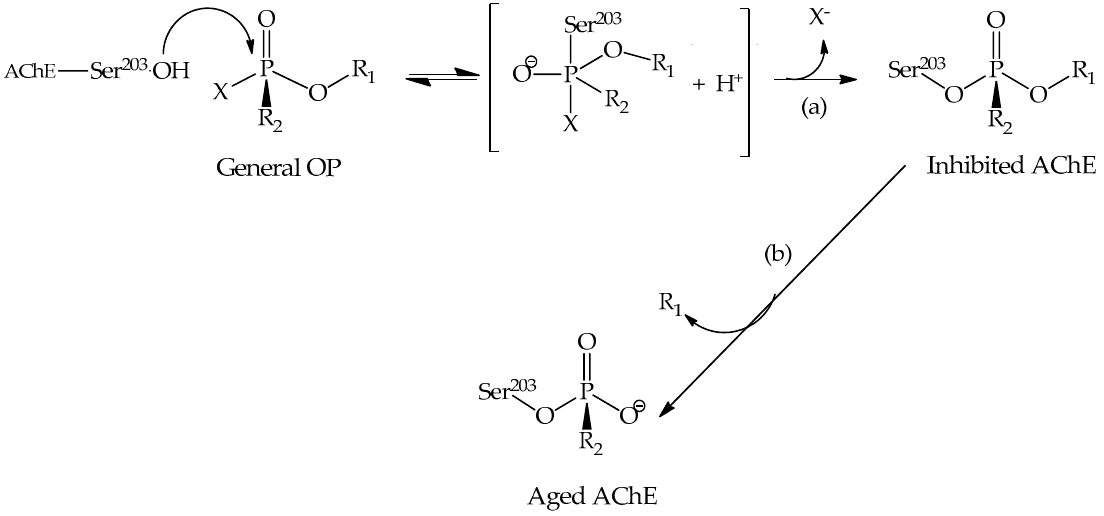
Figure 6. General representation of the ( a ) inhibition and ( b ) aging mechanisms [47].